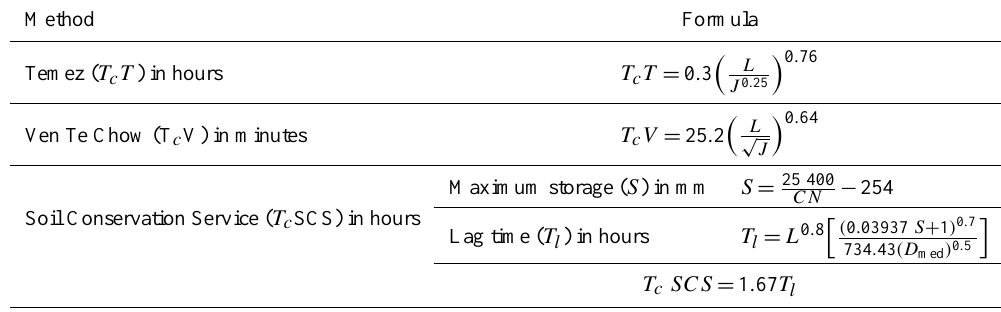
Table 2. Formulas for concentration time estimation (from Temez, 1978; Chow, 1964; SCS, 1973). Method Formula